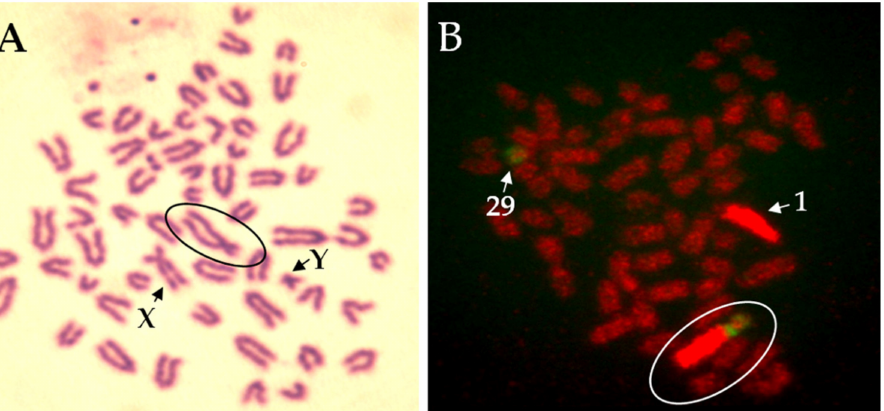
Figure 3. Robertsonian translocation 1;29 in bull (Slovak spotted breed). ( A ) Giemsa staining of chromosomes. ( B ) Fluorescence in-situ hybridisation (FISH) with whole chromosome painting probes for bovine chromosome 1 (BTA1, red) and 29 (BTA29, green). Circle indicates a